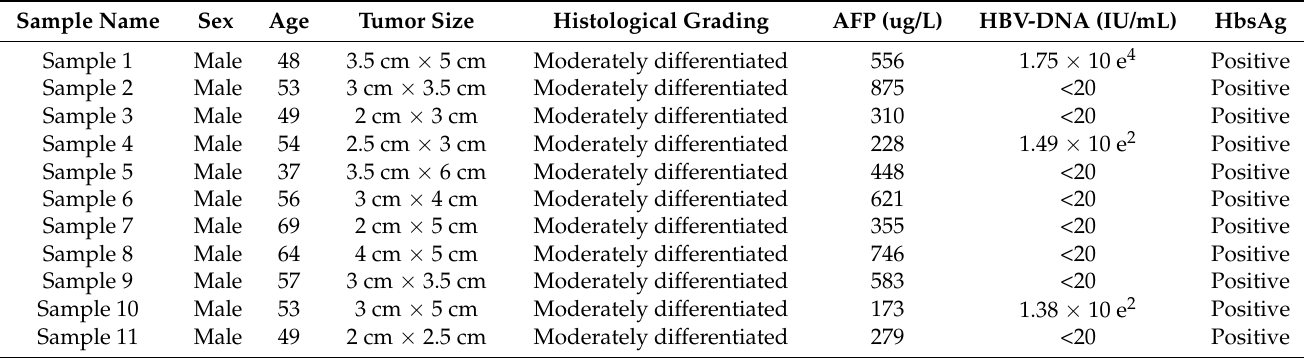
Table 1. Clinical characteristics of